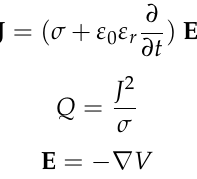
Figure 6. 2-D axisymmetric model for the FEM simulations.